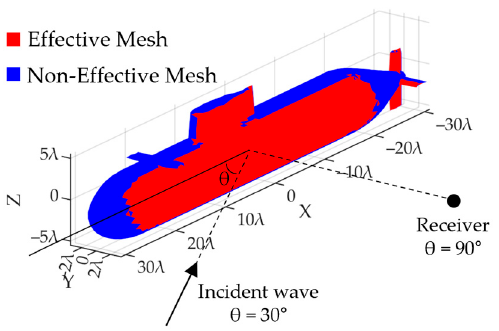
Figure 13. Meshed UUV model diagram. Effective mesh (red) and non-effective mesh (blue) accord- ing to angle of incidence and angle of reflection.